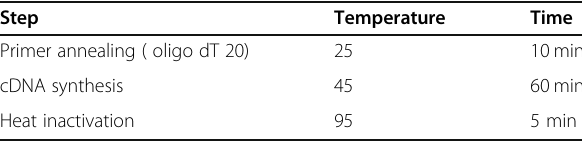
Table 2 Thermal cycling of cDNA synthesis